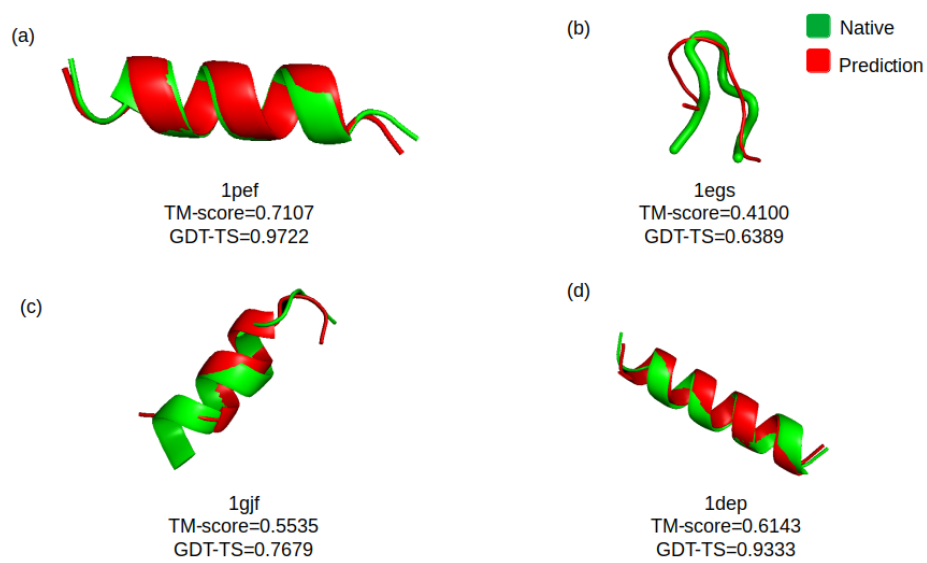
Figure 4. Three-dimensional models of peptides refined by GRSA2 (red) and the native structure (green). ( a – d ) show the superposition of the native and prediction structure for the peptides 1pef, 1egs, 1gjf, and 1dep, respectively.